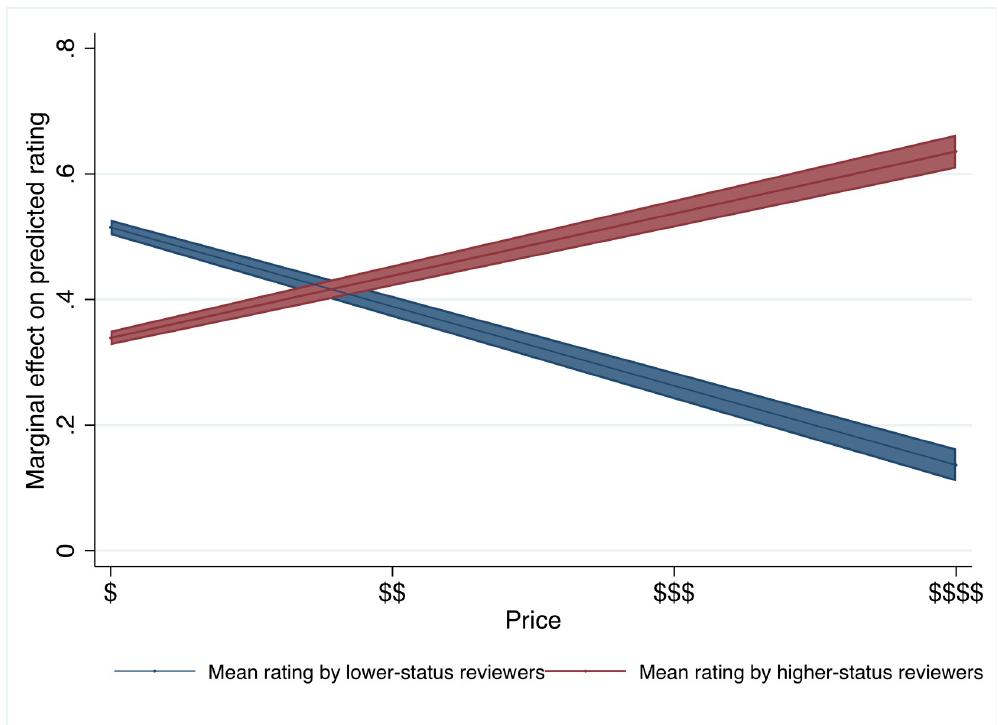
Fig 2. Marginal increase on a focal reviewer’s rating predicted by prior ratings by higher- and lower-class reviewers as a function of the organization’s price level. Study 1: Based on Model 3 in Table 2. The lines represent linear regression estimates, the shaded areas show the 95% confidence